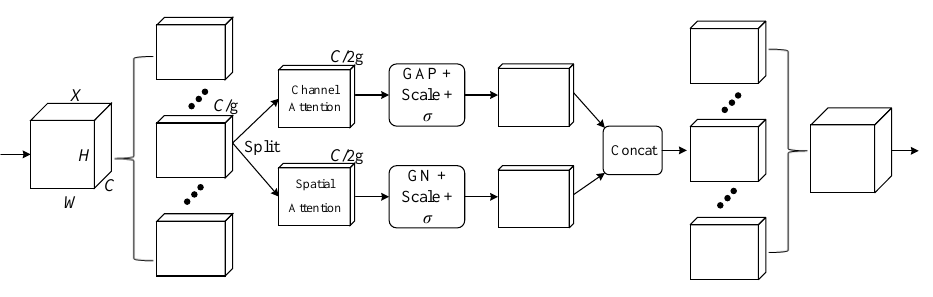
Figure 6. SA module-structure diagram.